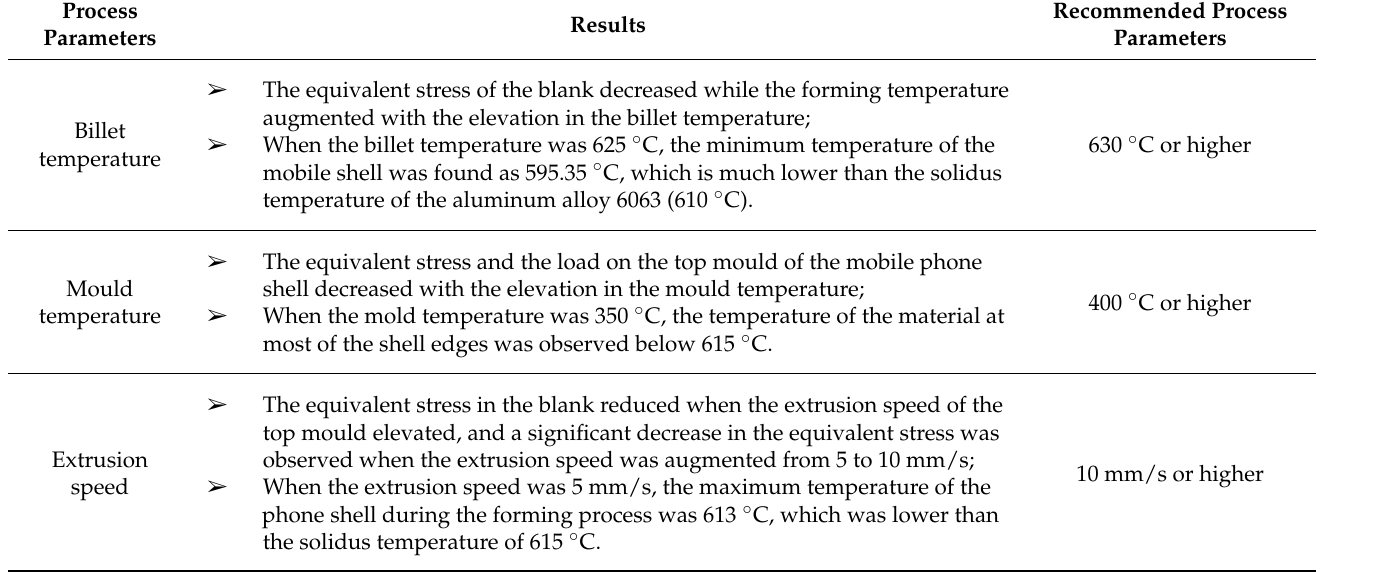
Table 3. Effects of process parameters on the SSTEF of mobile phone